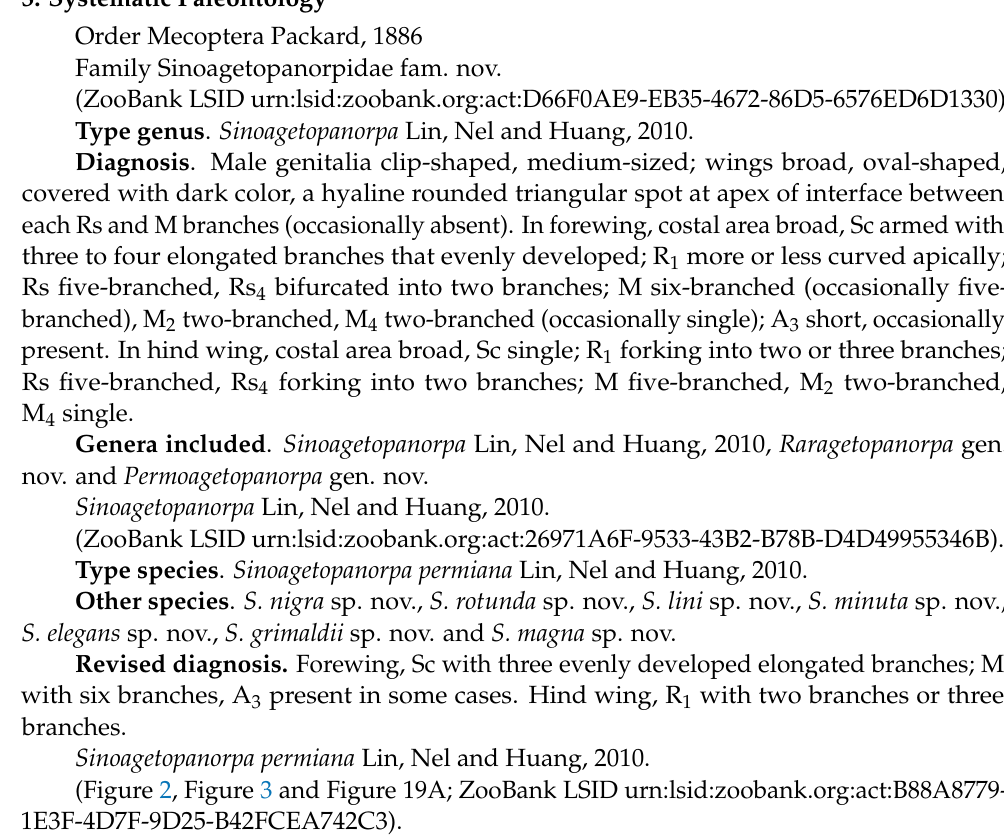
(Figure 2, Figure 3 and Figure 19A; ZooBank LSID urn:lsid:zoobank.org:act:B88A8779-